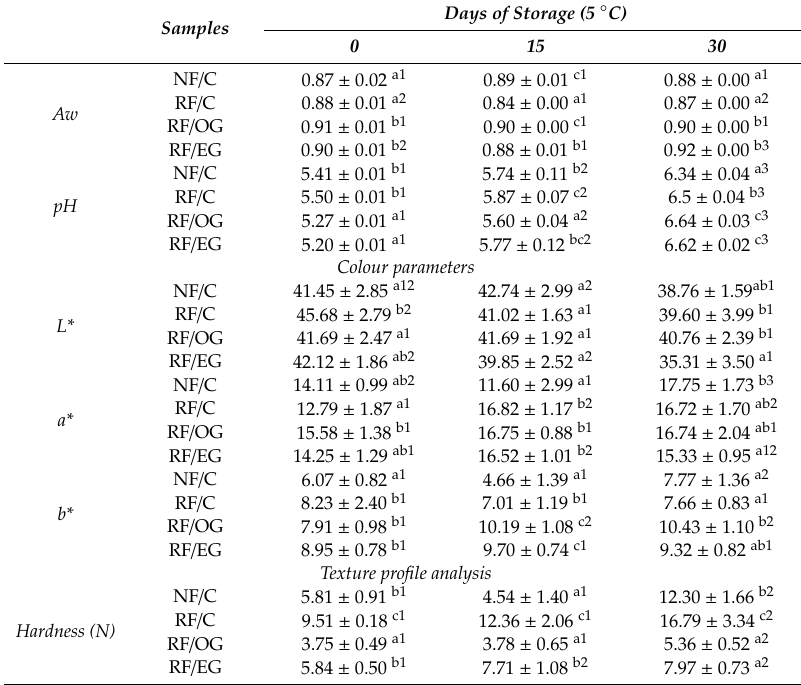
Table 4. Technological properties of fuets during chilled storage: pH and water activity (Aw) values, colour parameters (L* lightness, a* redness and b* yellowness) and texture profile analysis (TPA) (Hardness,